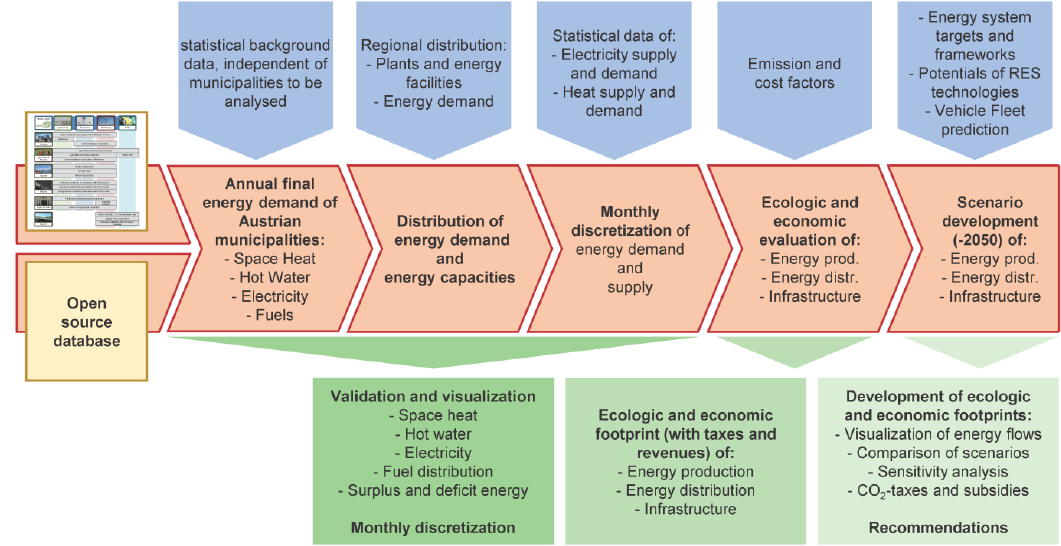
Figure 1. Methodology of ENECO 2 Calc.